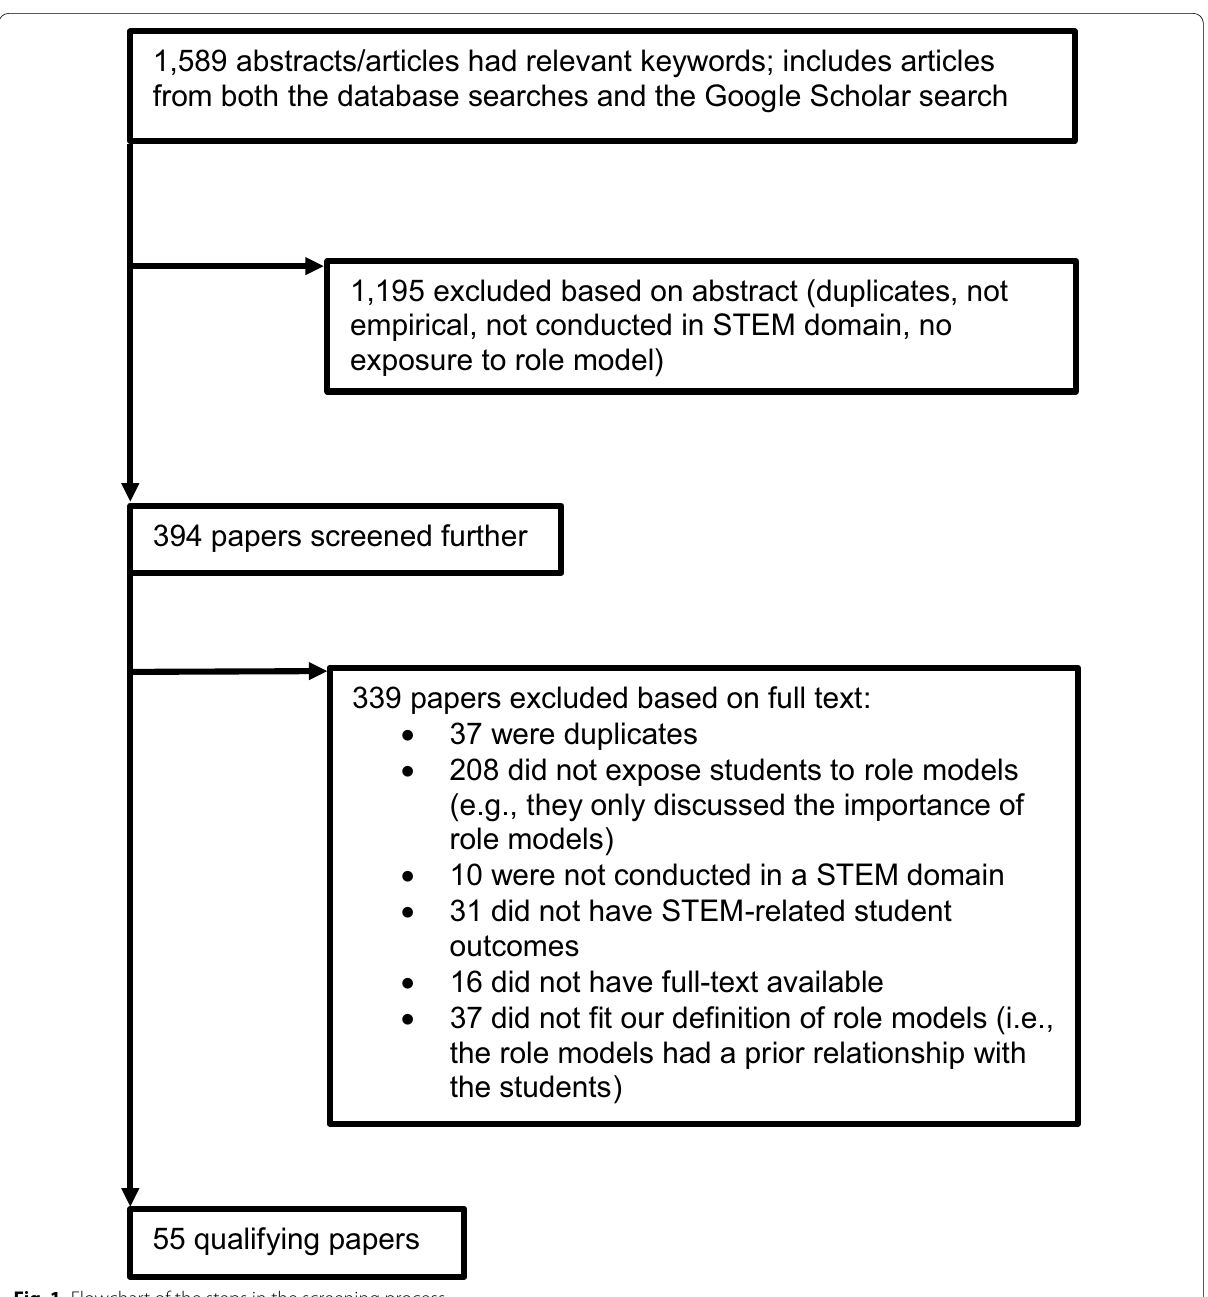
Fig. 1 Flowchart of the steps in the screening